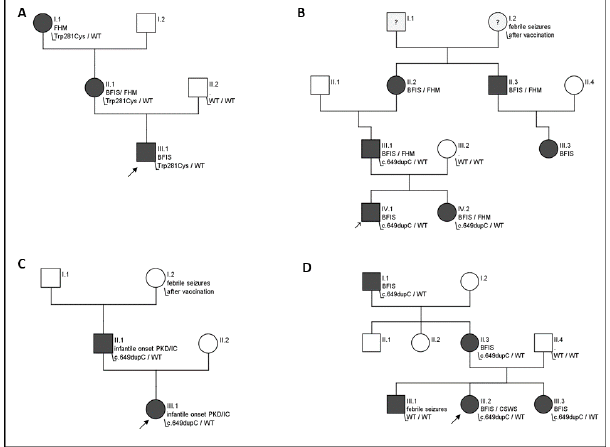
Figure 2. Pedigrees of affected families. Squares: male individuals, circles: female individuals, black circles/squares: clinically affected individuals, blank circles/squares: healthy individuals. Arrows indicating index patient. WT: wild-type; ( A ) family with the novel variant c.843C>G, p.(Trp281Cys) in three members displaying BFIS and/or FHM. Development of the index patient prior to seizure onset had been normal. Epilepsy gene panel diagnostic revealed a heterozygous missense variant at c.843C>G, p.(Trp281Cys). The variant was confirmed in the maternal grandmother. The mother had a history of infantile seizures and developed hemiplegic migraines later in life. The grandmother presented with hemiplegic migraine; seizures were not reported. No other movement disorders or neurologic disease were reported in the family; ( B ) family with five individuals with BFIS and severe hemiplegic migraines that started exceptionally early in two individuals. The index patient presented episodes of paroxysmal vertigo beginning at the age of 17 months in addition to benign infantile seizures consisting of clusters of bilateral tonic seizures beginning at four months of age. Under therapy with oxcarbazepine, the patient’s symptoms disappeared almost completely. The father and three relatives in the father`s family share a history of BFIS and hemiplegic migraine. The father has hemiplegic migraine with speech disturbance. The sister of the index patient developed BFIS without migraine. The index patient, his father and sister harbor the familial c.649dupC pathogenic variant; ( C ) family of two individuals presenting infantile PKD/IC. Seizures and dystonia started in the first half-year of life. The index patient and her father harbor the familial c.649dupC variant; ( D ) family of five affected individuals with BFIS and febrile seizures co-segregating with the familial c.649dupC pathogenic variant, one child developed continuous spikes and waves during slow sleep (CSWS). 3.6. Movement Disorders In the core cohort, 9 of 40 individuals (23%) developed movement disorders in addition to infantile seizures. In six of them, PKD started at the beginning of the second decade of life (10 to 14 years). In two individuals, dystonia started already in infancy (see next paragraph). One girl with bi- allelic variants in PRRT2 presented with episodic ataxia (EA) and non-epileptic myoclonus after minor head trauma (see: episodic ataxia with myoclonus after minor head trauma). In the extended cohort, four additional individuals reported movement disorders (13/102, 13%). 3.7. Paroxysmal Kinesigenic Dyskinesia with Infantile Onset In a single patient of the core cohort, in whom BFIS started at four months of age, dystonia soon followed at the age of five months (Figure 2C). The girl displayed up to 20 episodes per day of short dystonic inclination of the head to the right side, grimacing, elevation of the right shoulder, and